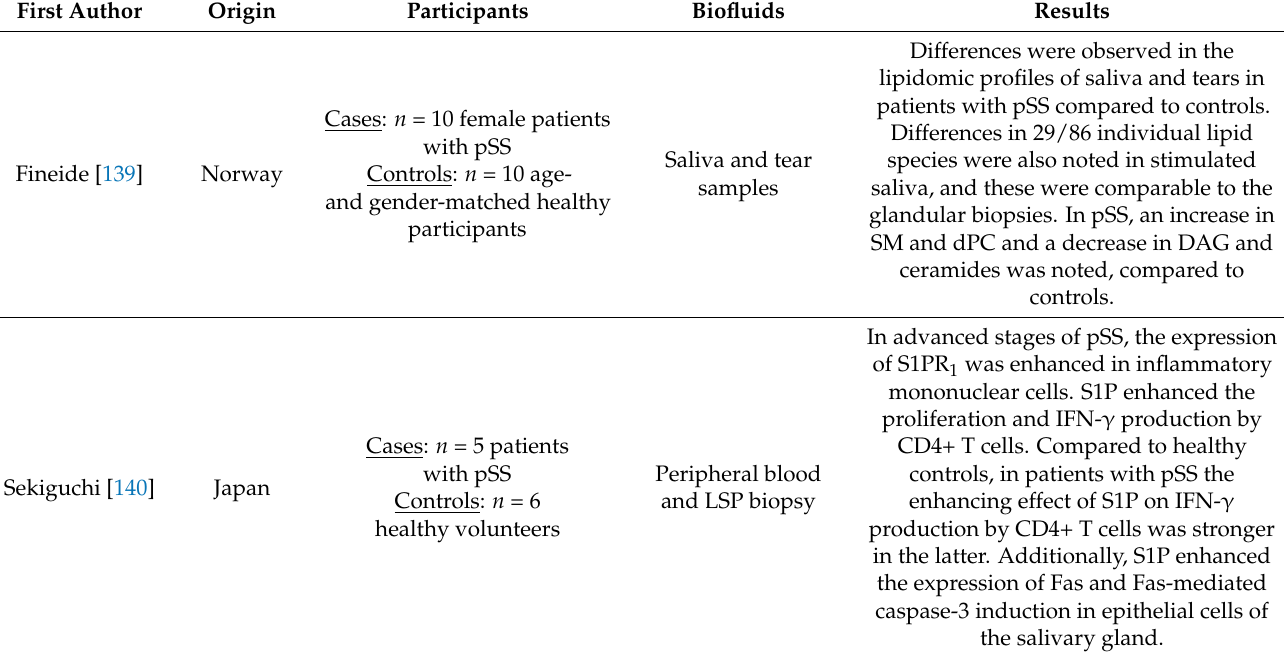
Table 5. Summary of case-control studies assessing ceramide levels in patients with